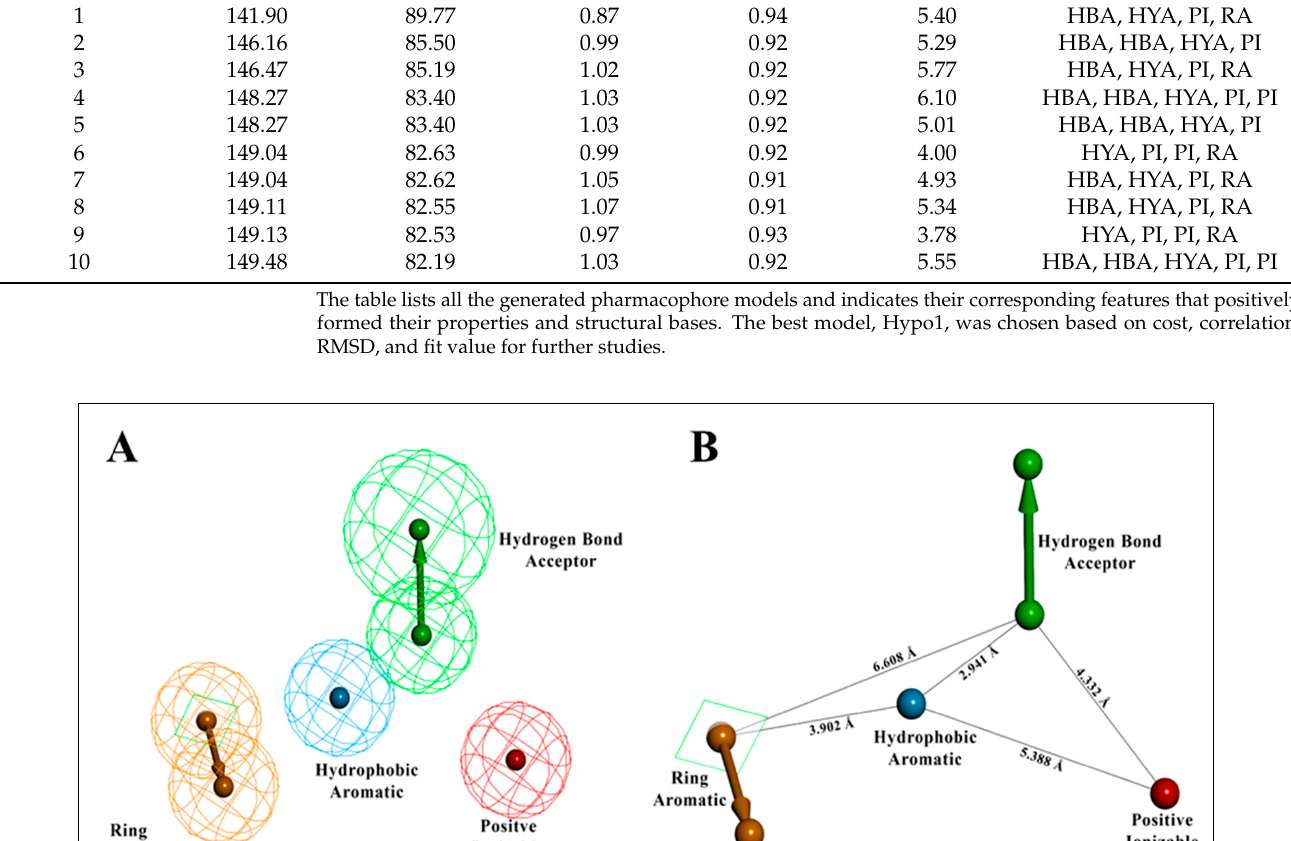
Table 1. Statistical outcomes of the top 10 pharmacophore hypotheses generated by the HypoGen algorithm.